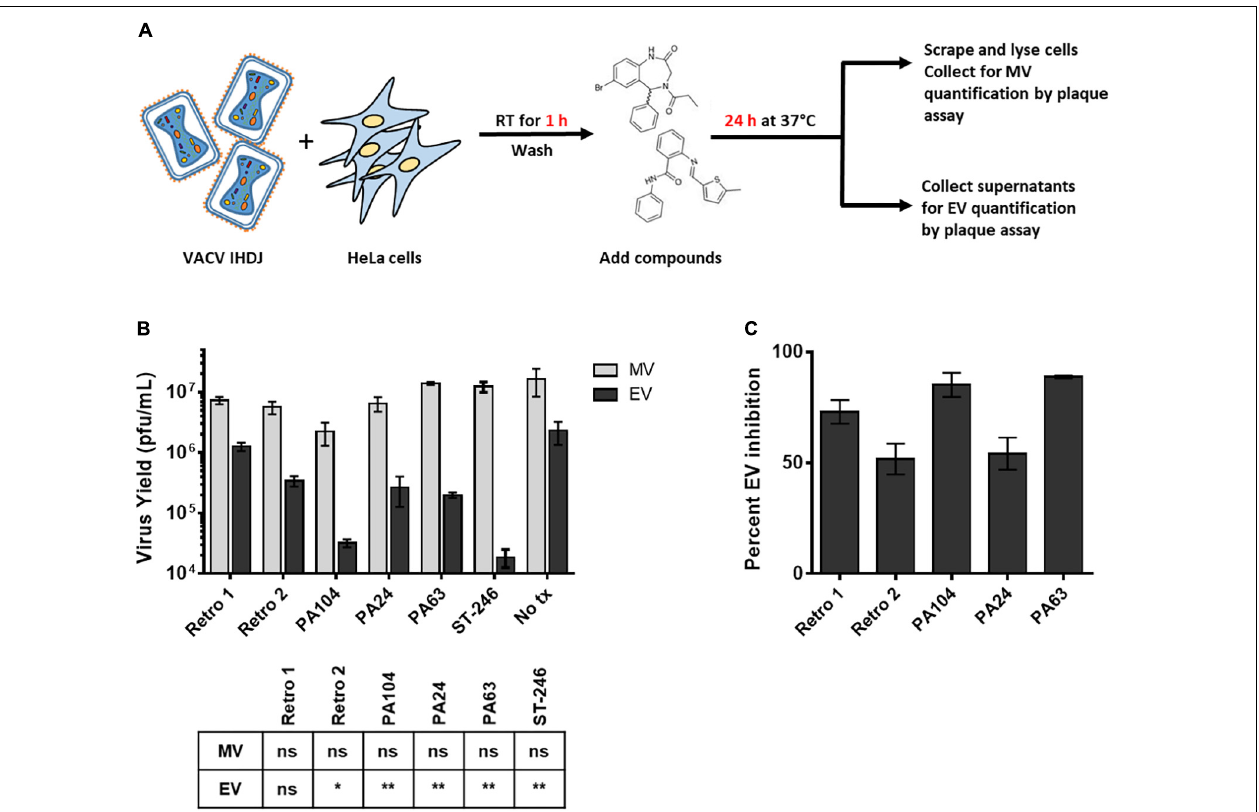
FIGURE 3 | Reduced EV formation in the presence of Retro-1 analogs. (A) Schematic representation of assay used to determine MV and EV yield in the presence of Retro-2 and Retro-1 analogs. (B) Mature virus (light gray) and EV (black) yield (pfu/mL) in the presence of 2.5 µ M retrograde inhibitors. Values represent the average of three replicates. The results of one-way analysis of variance and post hoc Sidak multiple-comparisons test comparing the three replicates ( n = 3) of each compound to no treatment control are tabulated below graph: ns = not significant, * p ≤ 0.05 and ** p ≤ 0.005. (C) Percent inhibition of EV formation in the presence of 2.5 µ M retrograde inhibitors. Values calculated based upon yield data shown in (B) . Values in both (B) and (C) represent average ±